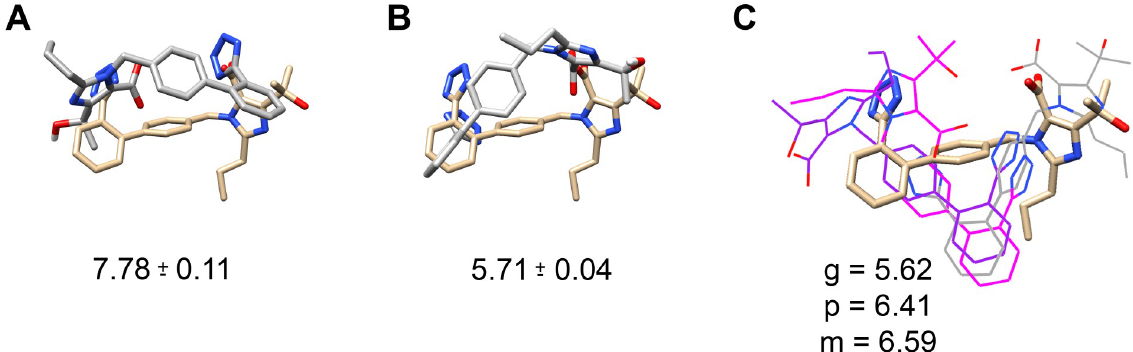
Fig 4. Docking poses of Olmesartan to the apo-AT 1 R model. A , AutoDock 4.2, B , AutoDock Vina, and C , MOE were used to dock Olmesartan to the apo-AT 1 R model and compared it to the orientation of Olmesartan in the AT 1 R crystal structure (4ZUD) shown in tan. The Boltzmann weighted average predicted affinity in -log[M] for each docking run is listed under the image. MOE, C , was used to create three different docking scenarios: standard docking (grey), manually setting the tetrazole to -1 charge (purple), and allowing for flexible receptor residues (magenta). For clarity, the MOE dockings are shown as lines.